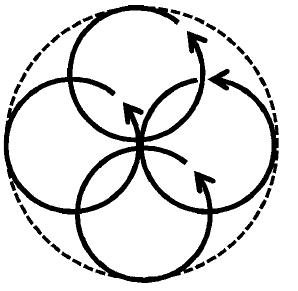
FIG. 7. Combination of several rotating coil measurements. FIG. 8. Block diagram of the measurement